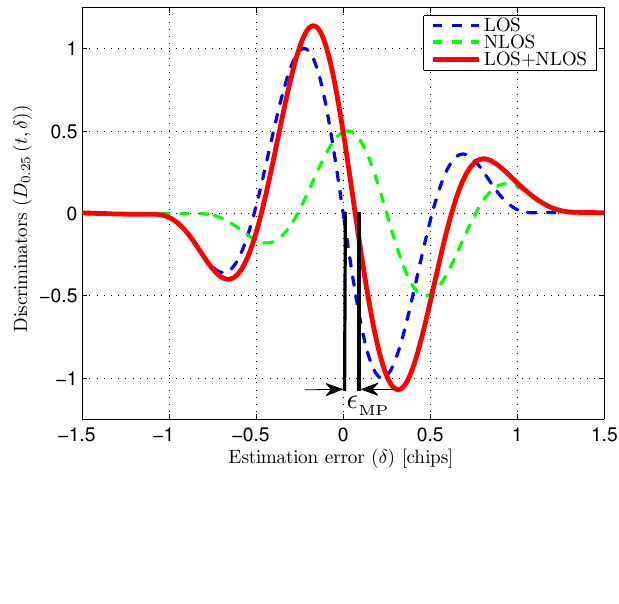
Figure 8. Discriminator functions associated to LOS, NLOS and composed signal (NLOS to LOS optical power ratio = 25 %